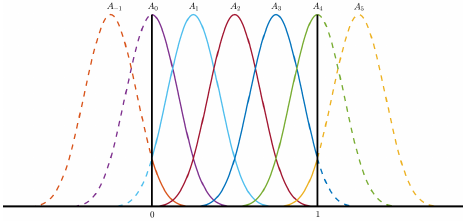
Figure 1. A cubic B-spline generalized uniform fuzzy partition of [ 0,1 ]